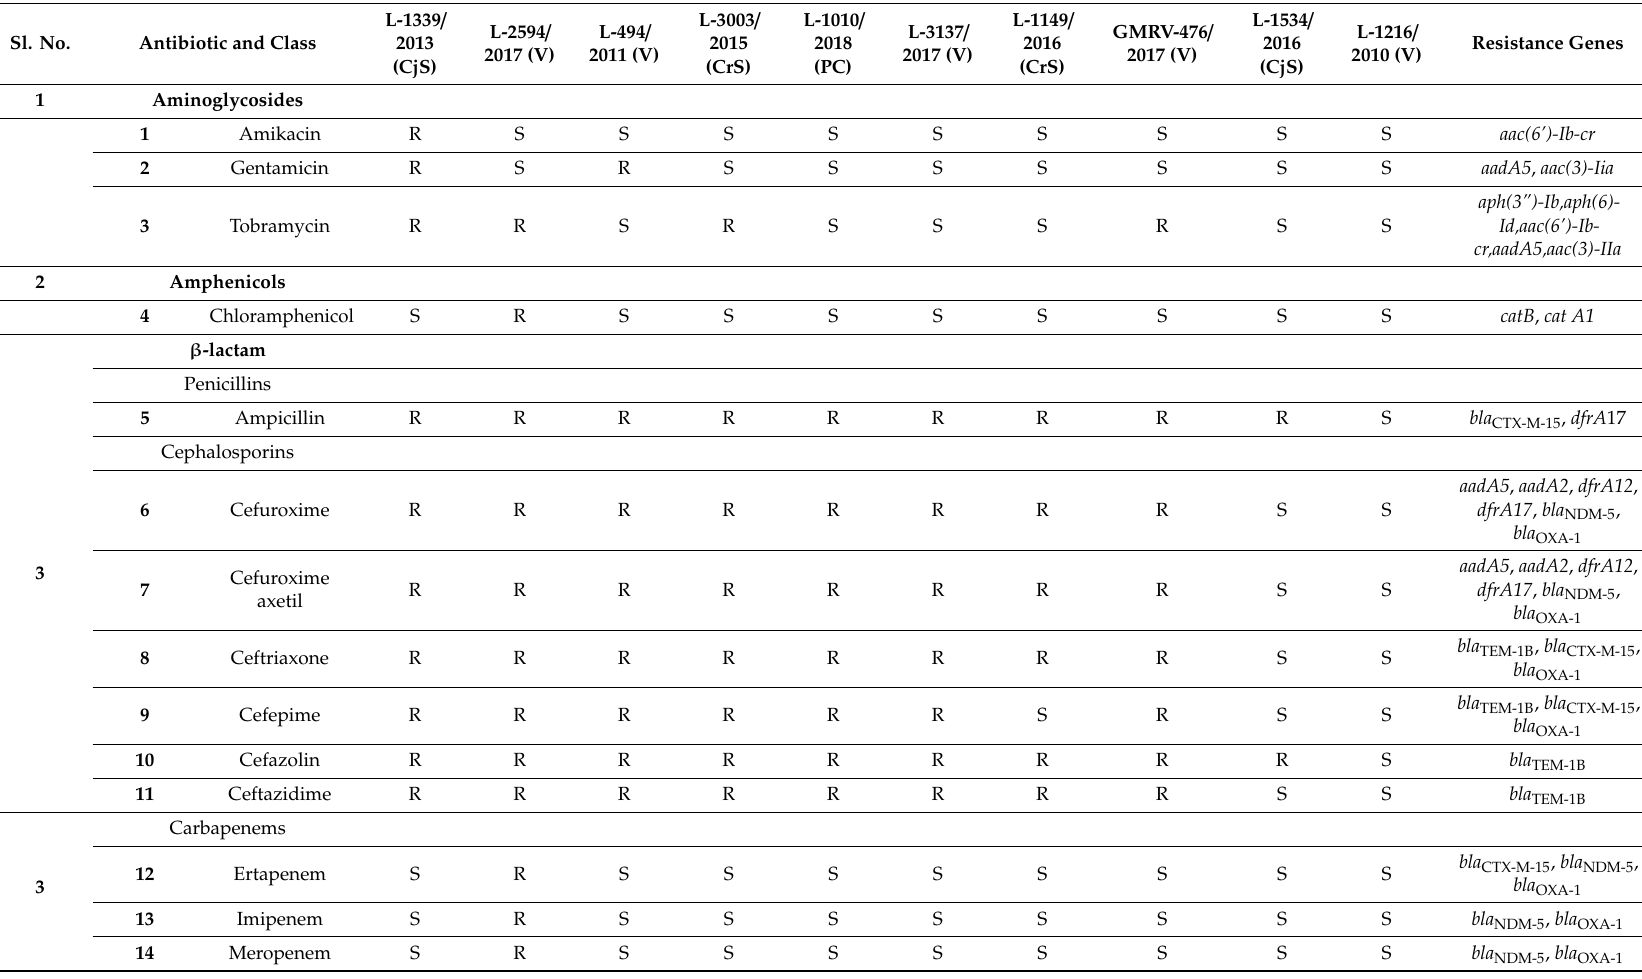
Table 3. ( A ) Susceptibility of the 10 ocular E. coli isolates * to 29 di ff erent antimicrobial agents belonging to seven di ff erent classes; ( B ) Comparison of the resistance profile of the ocular and urine isolates of E. coli from patients with ocular disease to 11 di ff erent antimicrobial agents. Sl.